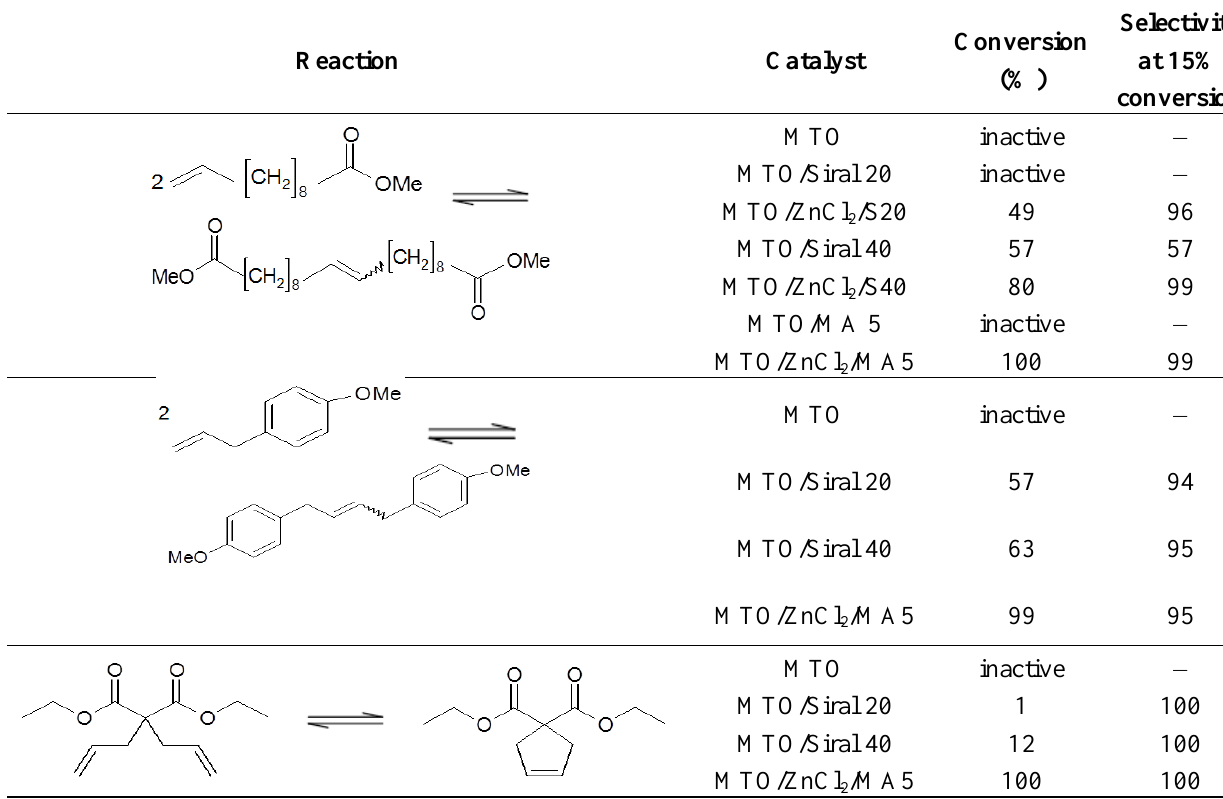
Table 6. Metathesis reactions of model compounds over homogeneous or heterogenized